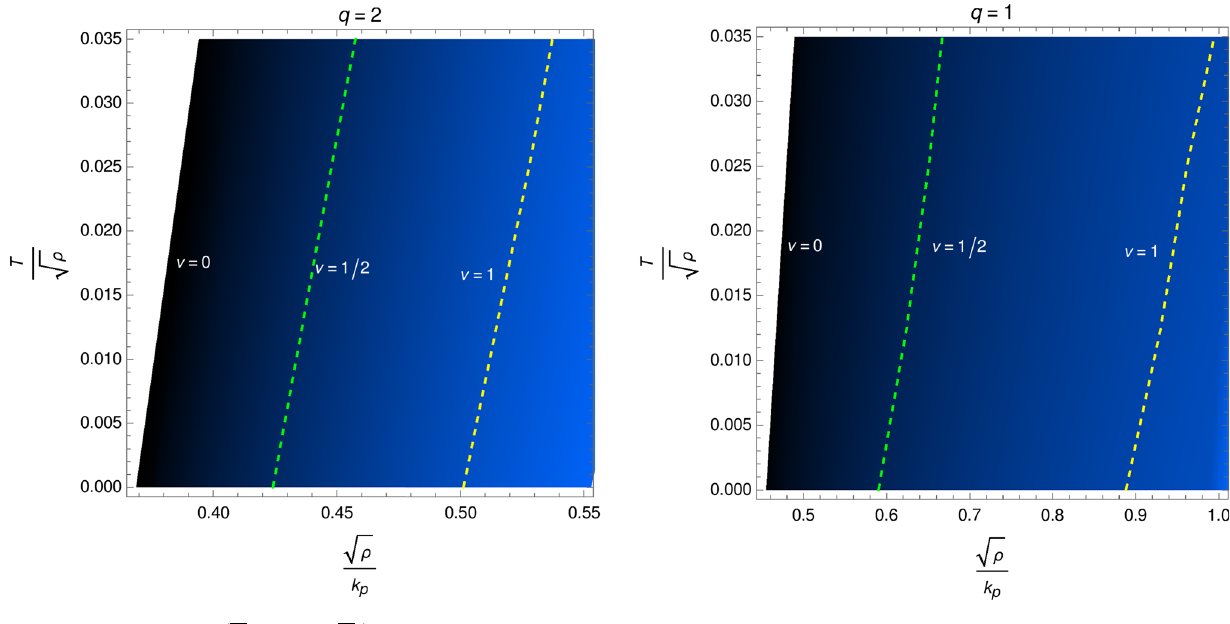
√ √ ρ vs. ρ/k q = 1. p plane for